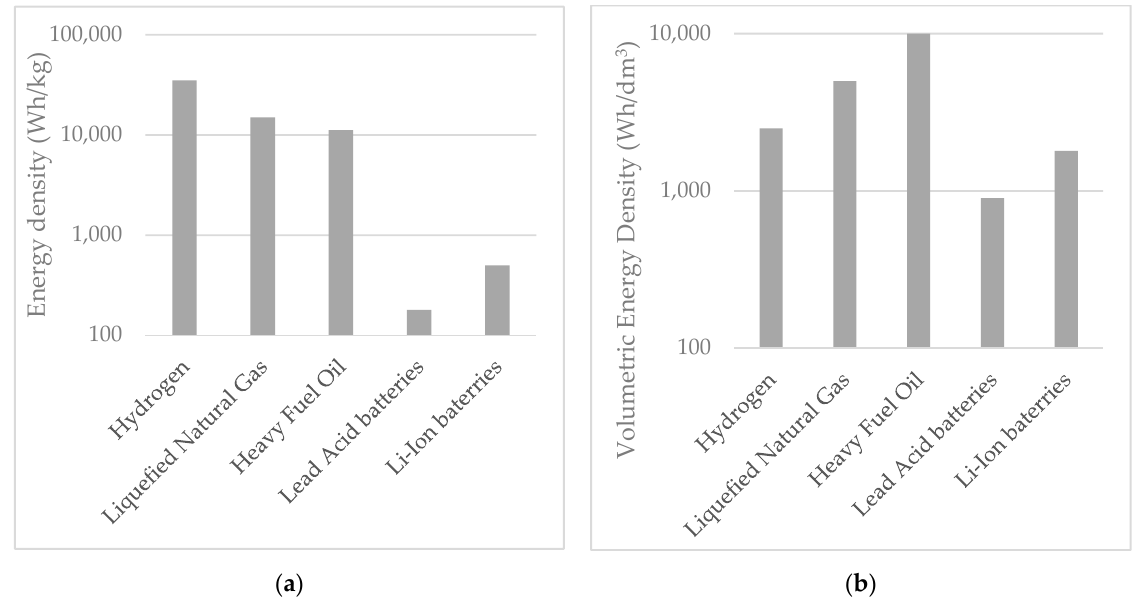
Figure 1. Energy sources comparison: ( a ) Gravimetric energy density; ( b ) Volumetric energy density [16–18].